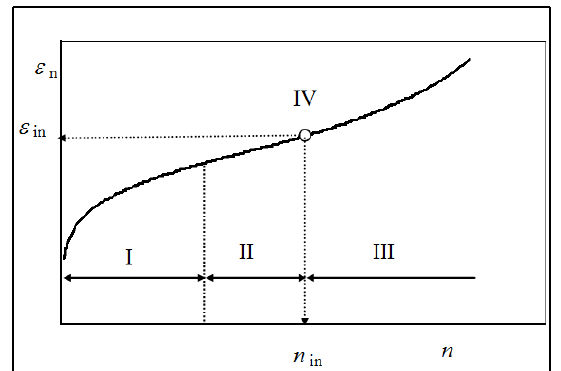
Figure 1. Schematic illustration of the creep curve (I, II, III-creep phases, IV- inflection point)